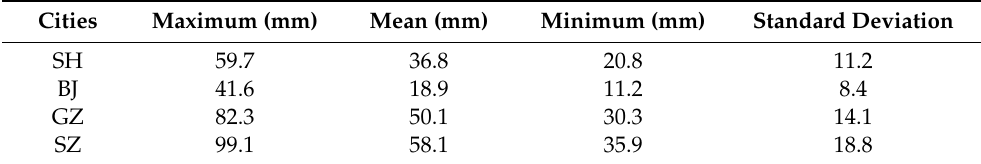
Table 2. Information of Rx3h series in study